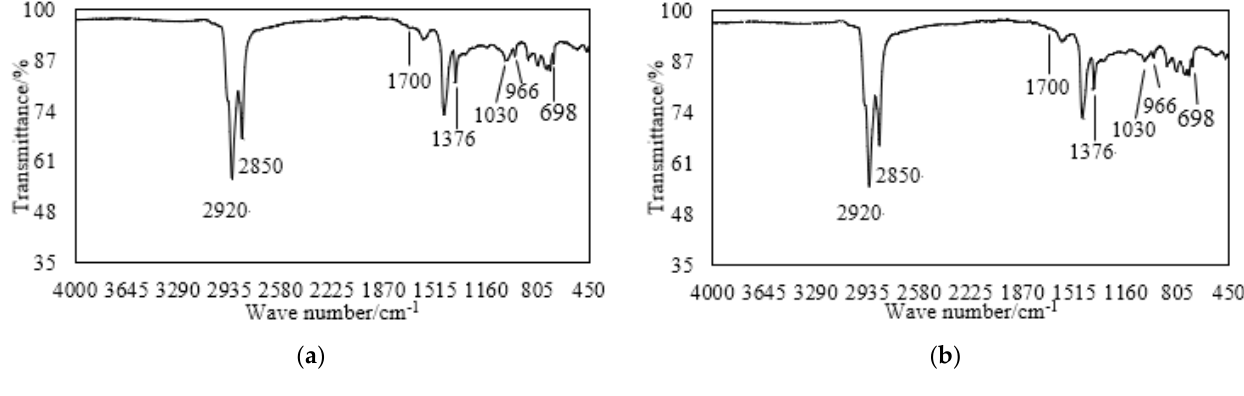
Figure 11. FTIR spectrum of asphalt extracted from unaged mixture: ( a ) BFSMA-13, ( b ) LFSMA-13.